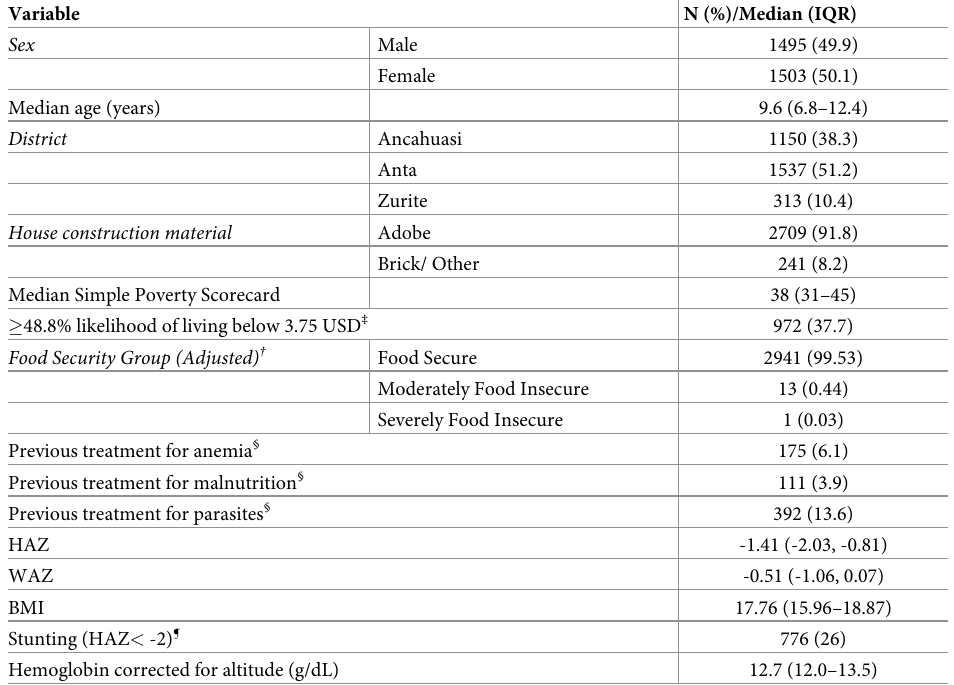
Table 1. Demographic, socioeconomic, and clinical characteristics of the participants.